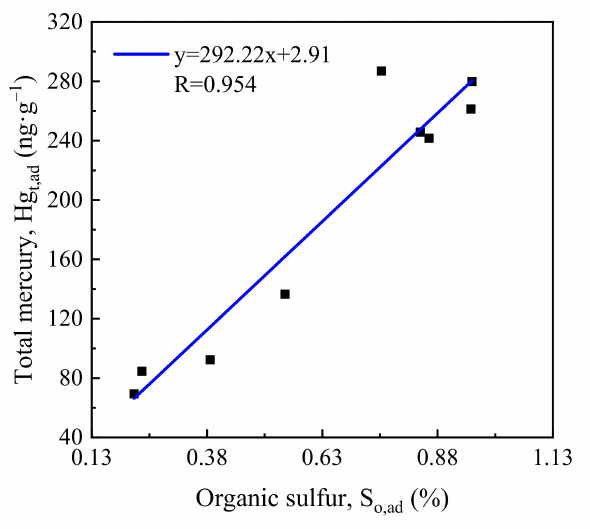
Figure 7. Correlation between Hg and organic sulfur in